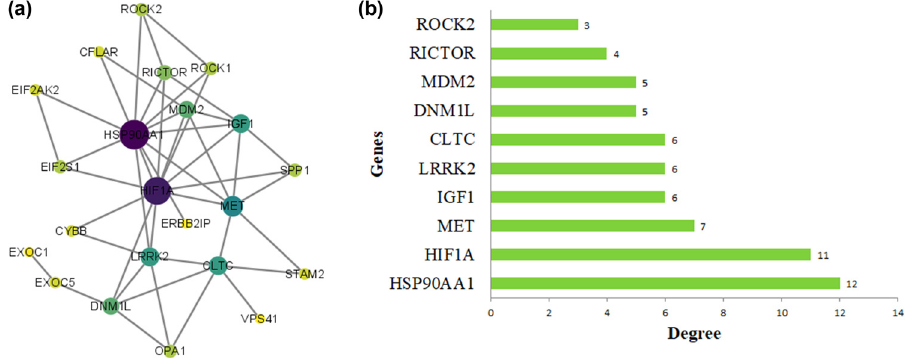
Figure 5: PPI network analysis of the DEARGs: ( a ) PPI network of DEARGs. The color and size of nodes indicate the value of a degree, the larger and deeper a node, the more important it is in the network. ( b ) Top ten genes of DEARGs by degree score ranking.